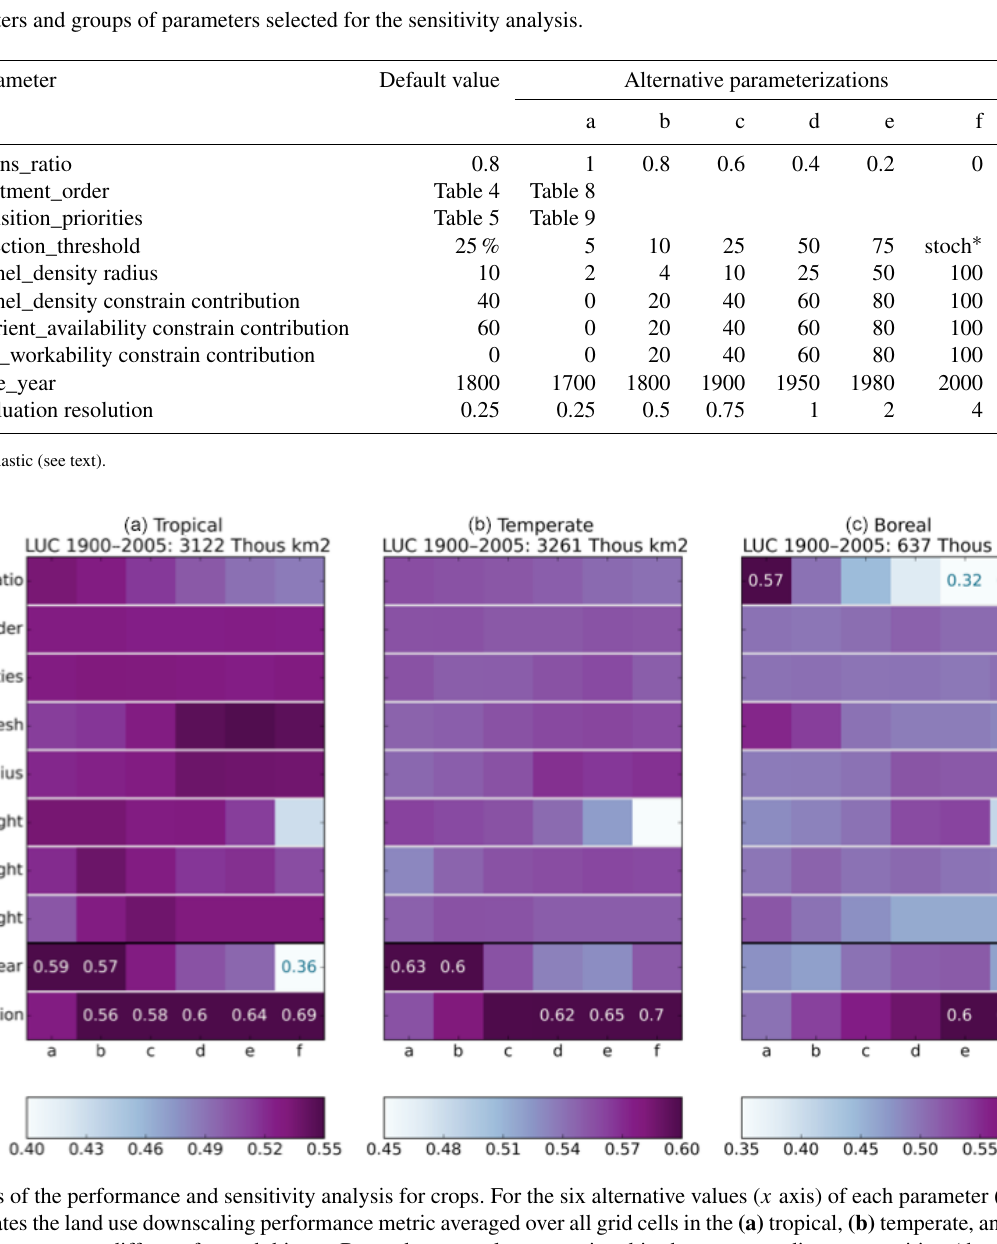
Table 7. Parameters and groups of parameters selected for the sensitivity analysis.